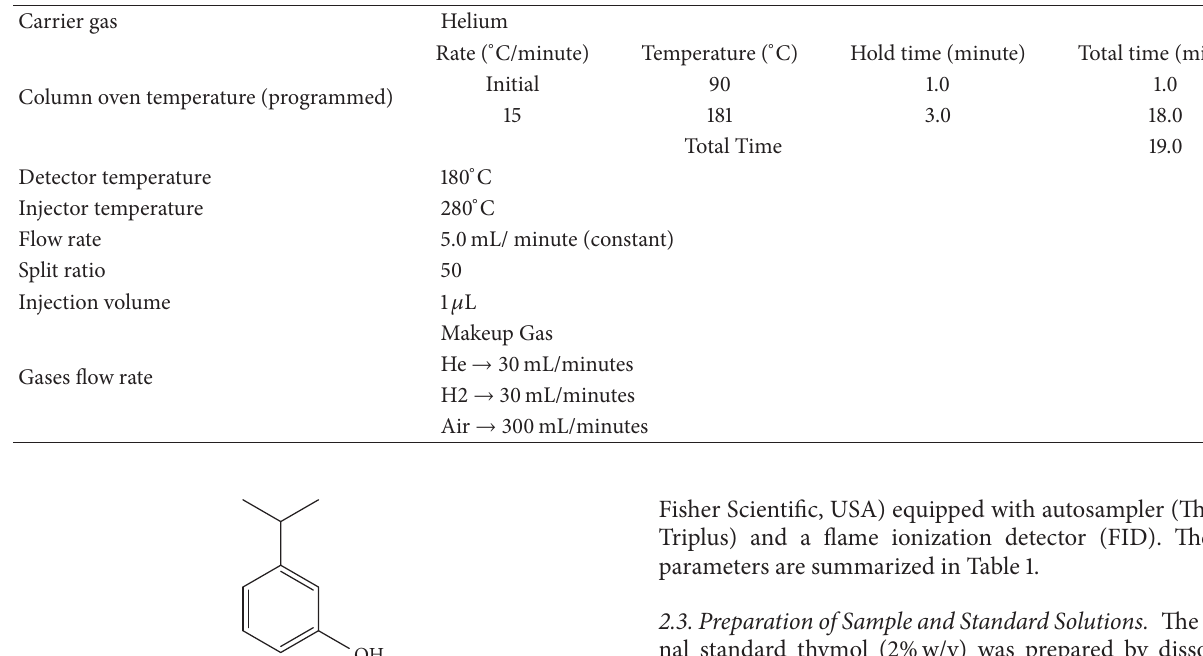
Table 1: The GC parameters.